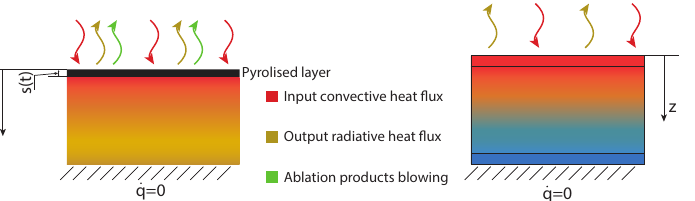
Figure 9. Applied thermal boundary conditions for ( left ) an ablative material and ( right ) for an homogenised ITPS with different